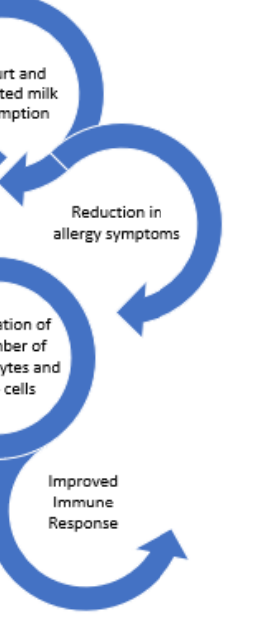
Figure 6. Effect of yoghurts and fermented milk consumption on the immune system.